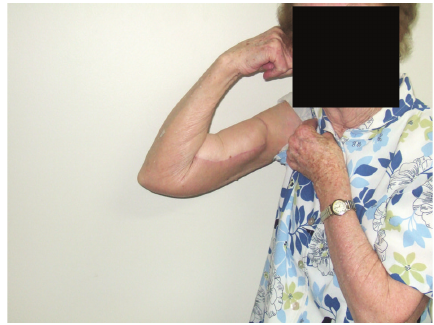
Figure 4: Patient treated for MFH of the anterior compartment of the arm; the resection involved the biceps and the brachialis muscles, and denervation of brachioradialis. The reconstruction has been obtained using free innervated gracilis and transfer of FCU to remaining brachialis. Clinical outcome at 12 months post-op shows full active flexion at the elbow. The muscle strength of the anterior compartment of the arm was